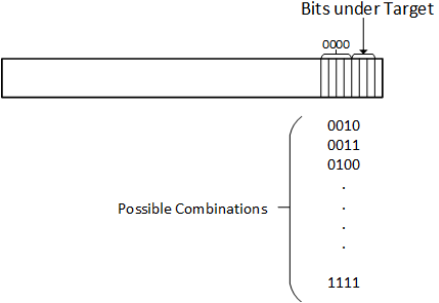
Figure 3. Key Bits Under